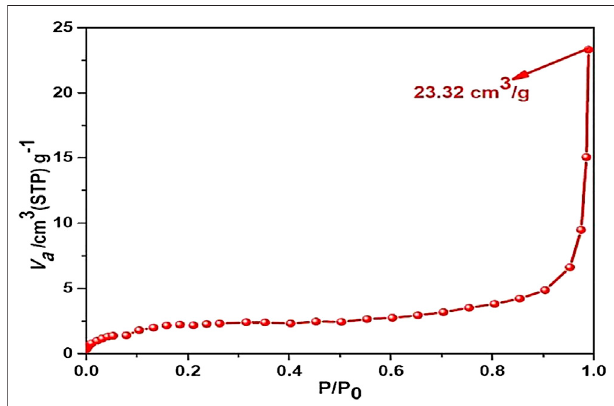
FIGURE 6 | Carbon dioxide adsorption of Fe – Ag co-doped TiO 2 NPs.